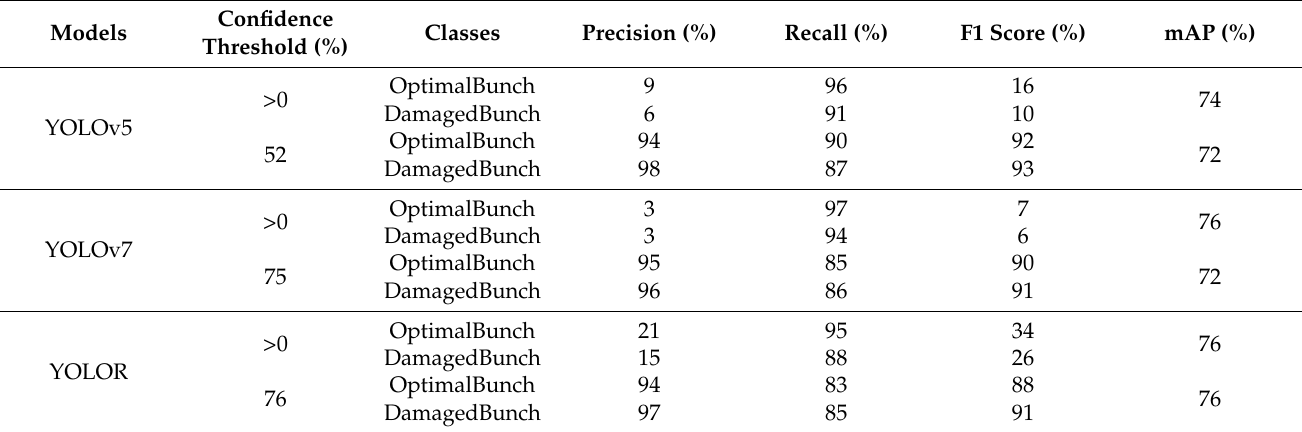
Table 9. Detection results with the test set of Grapevine Bunch Condition Detection Dataset consider- ing different confidence